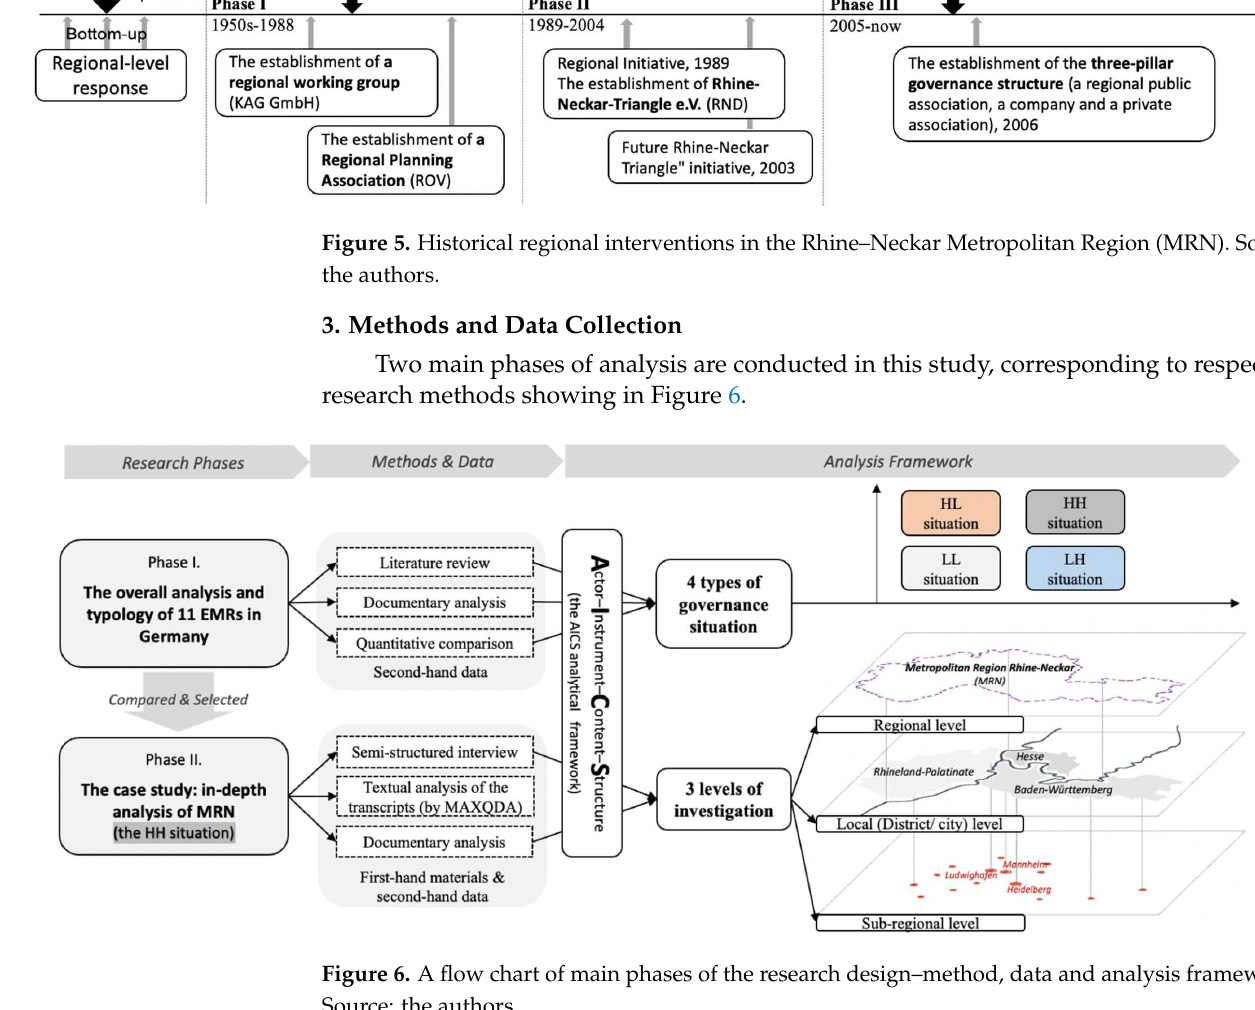
Figure 5. Historical regional interventions in the Rhine–Neckar Metropolitan Region (MRN).